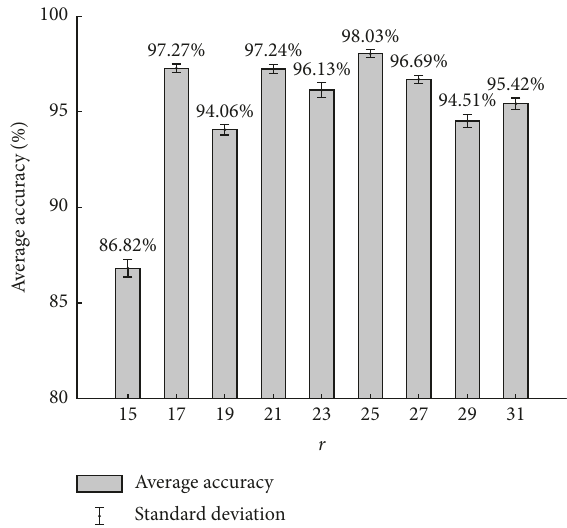
Figure 9: The average accuracy corresponding to the different r values ( S h � 0.7).